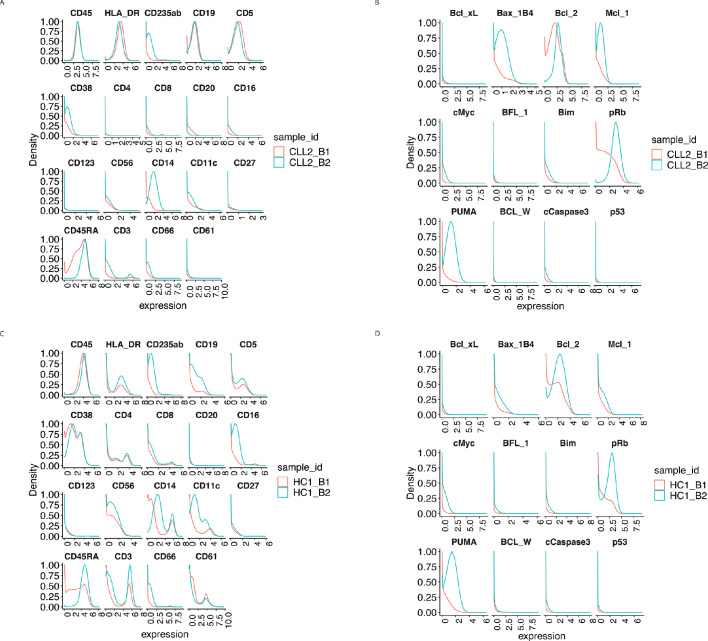
Protein distributions before normalisation for the samples CLL2 and HC1 across batch 1 and batch 2.(A) Lineage protein expression distributions for the sample CLL2 across batches, before normalisation. (B) Same as (A) with functional proteins. (C) Lineage protein expression distributions for the sample HC1 across batches, before normalisation. (D) Same as (C) with functional proteins.